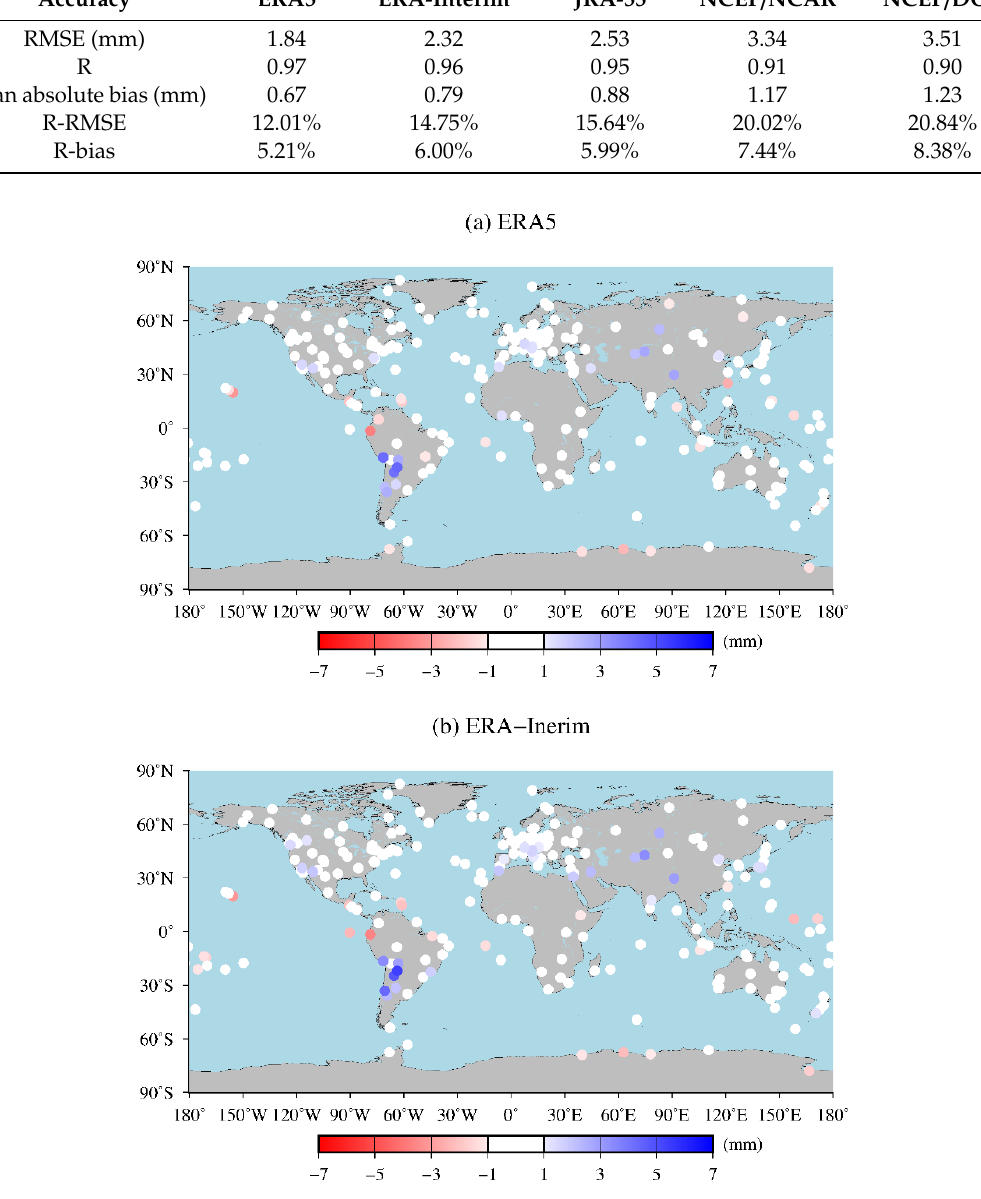
Figure 2. The change of RMSE values for ERA5, ERA ‐ Interim, JRA ‐ 55, NCEP/NCAR, and NCEP/DOE reanalysis water vapor products relative to GNSS PWV with the change of height difference between GNSS and five reanalysis products (source: own